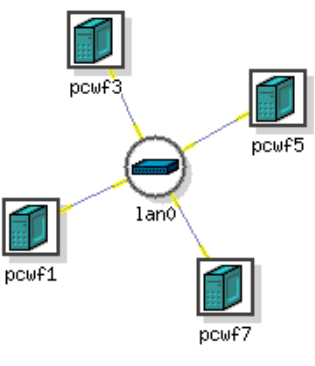
Fig. 17. Configuration of nodes can be verified to communicate via wireless channel through ifconfig command at remote nodes.